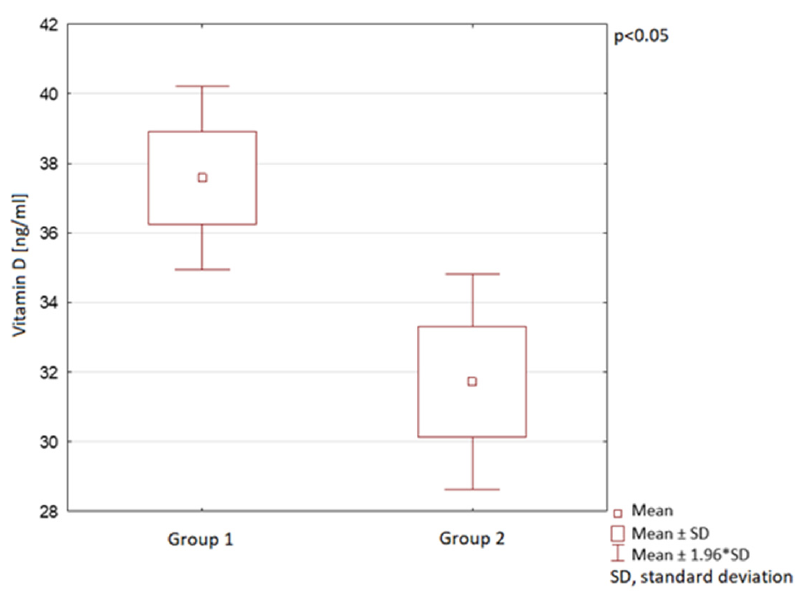
Figure 6. Vitamin D serum levels in spring in children in the compared groups.